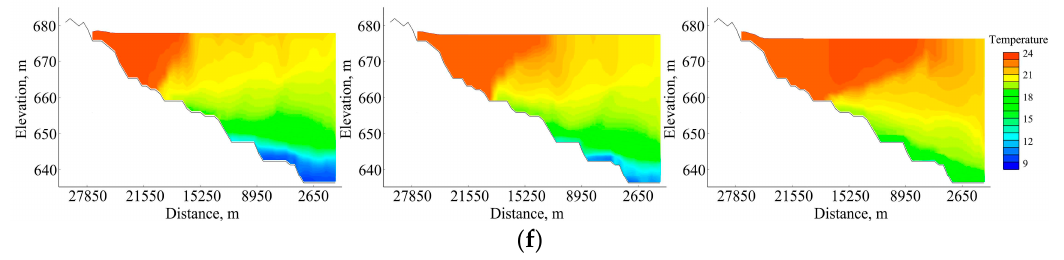
Figure 8. Results of thermal stratification simulation: ( a ) Initial thermal stratification of the reservoir; ( b ) inflow, 40 m 3 /s and outflow, 40 m 3 /s (from left to right: 1 day, 3 days, 5 days); ( c ) inflow, 100 m 3 /s and outflow, 100 m 3 /s (from left to right: 1 day, 3 days, 5 days); ( d ) inflow, 140 m 3 /s and outflow, 140 m 3 /s (from left to right: 1 day, 3 days, 5 days); ( e ) inflow, 100 m 3 /s and outflow, 80 m 3 /s (from left to right: 1 day, 3 days, 5 days); ( f ) inflow, 100 m 3 /s and outflow, 120 m 3 /s (from left to right: 1 day, 3 days, 5 days). Table 2. The time taken to reach suitable ecological water temperature under different inflow and outflow scenarios.